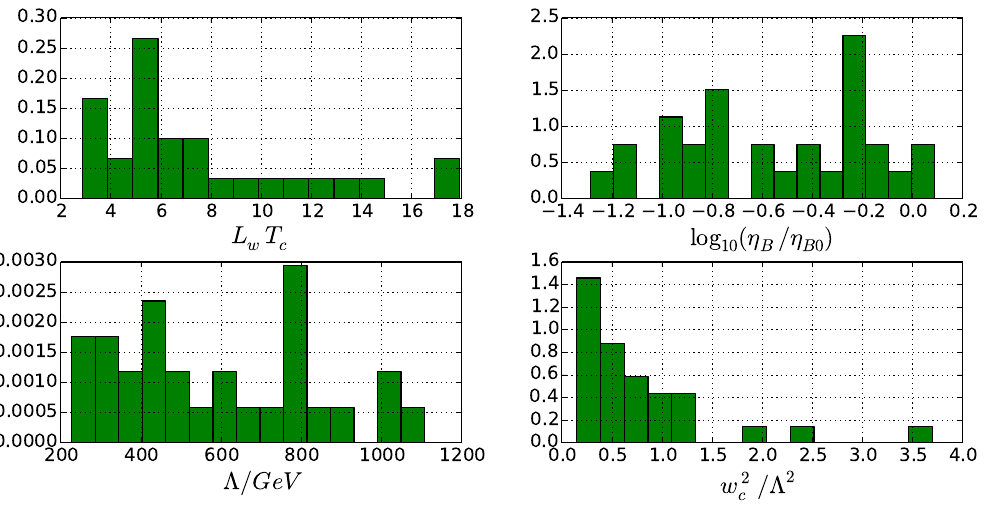
Figure 7 . The same distributions as in (cid:12)gure 5 but for the second scan of models which tries to explain the DM relic abundance and the baryon asymmetry in the Universe